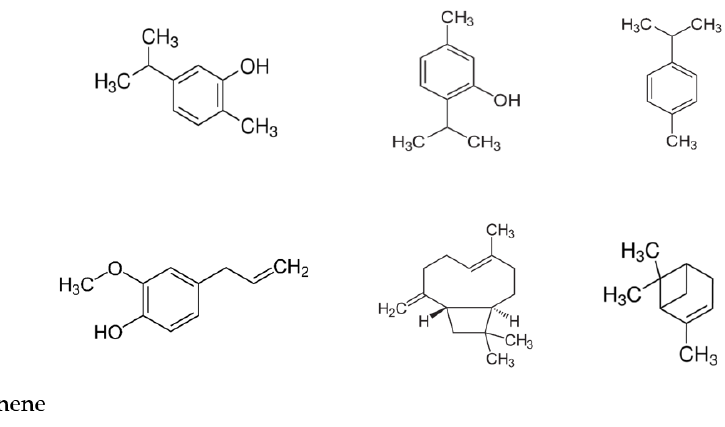
Figure 1. Bioactive terpenes isolated from ( A ) T. vulgaris and ( B ) J. procera